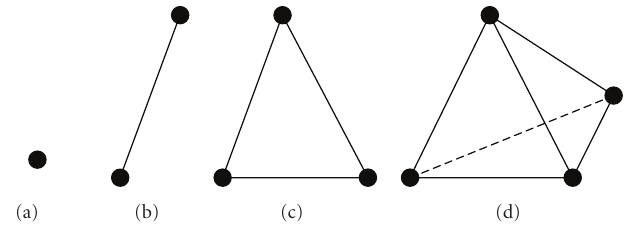
Figure 4: (a) 0-simplex, (b) 1-simplex, (c) 2-simplex, and (d) 3-simplex of R 3 .